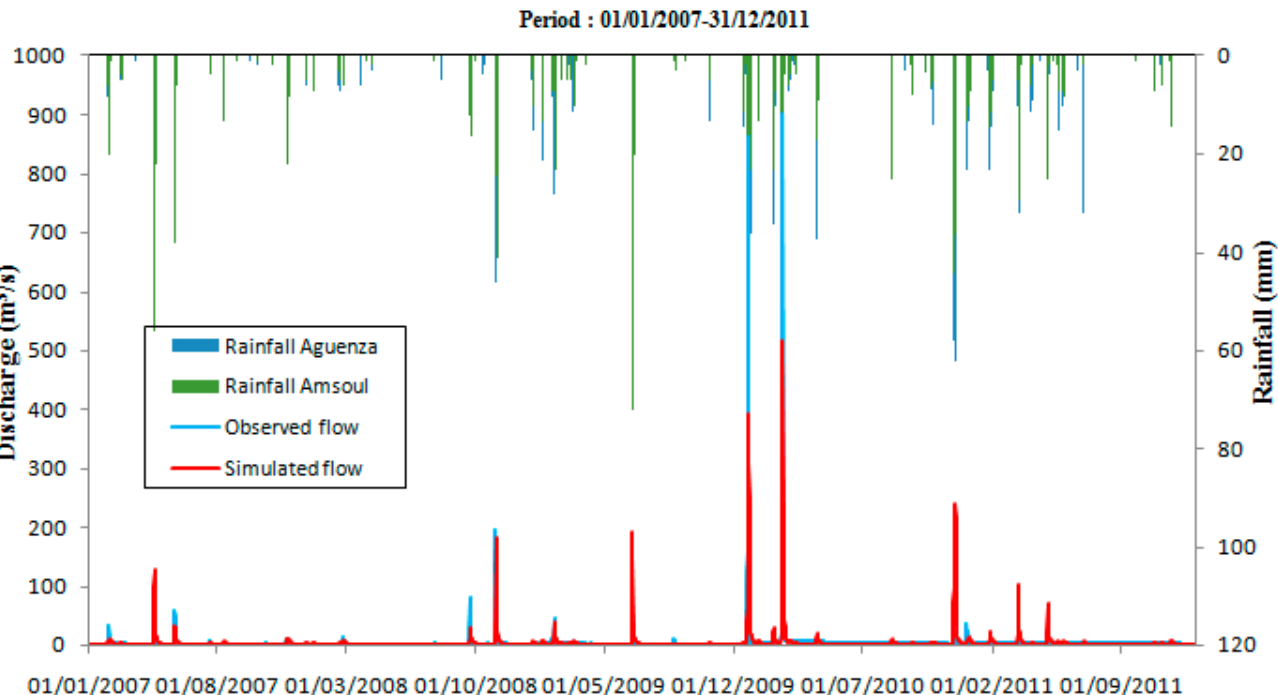
Figure 11. Graphical illustration of the ATHYS model output during the validation period (2007–2011).